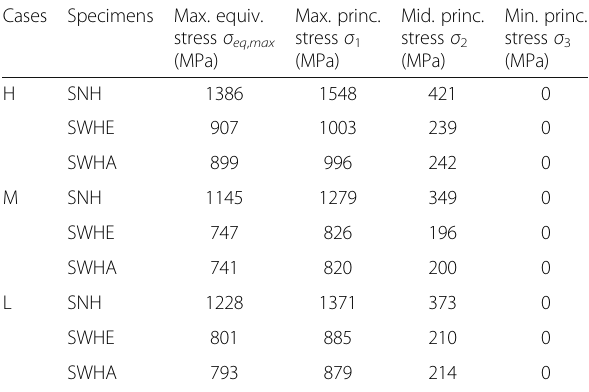
Table 6 Stresses at the reference point of the different